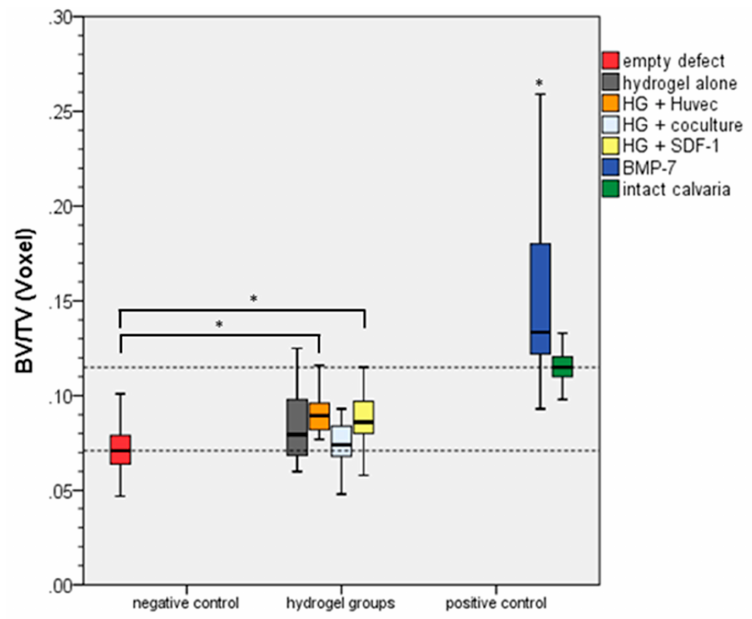
Figure 2. Quantitative evaluation employing the BV/TV method. The positive control groups are significant different to all other groups (*). From the hydrogel groups only the two groups HG- HUVEC and HG-SDF1 demonstrated significant differences compared to the negative control (*, p ≤